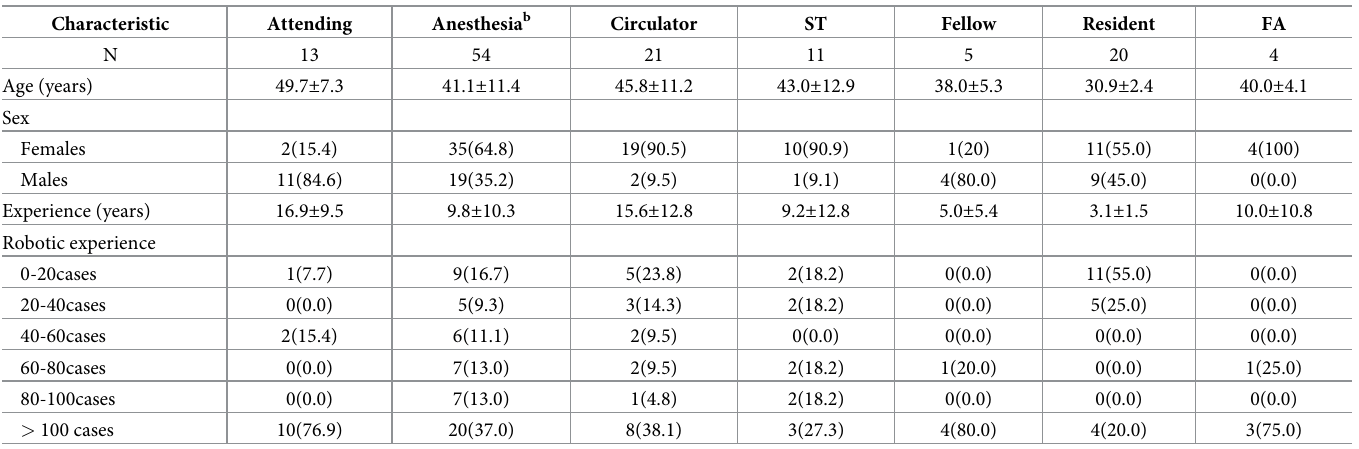
Table 2. Participants demographics a